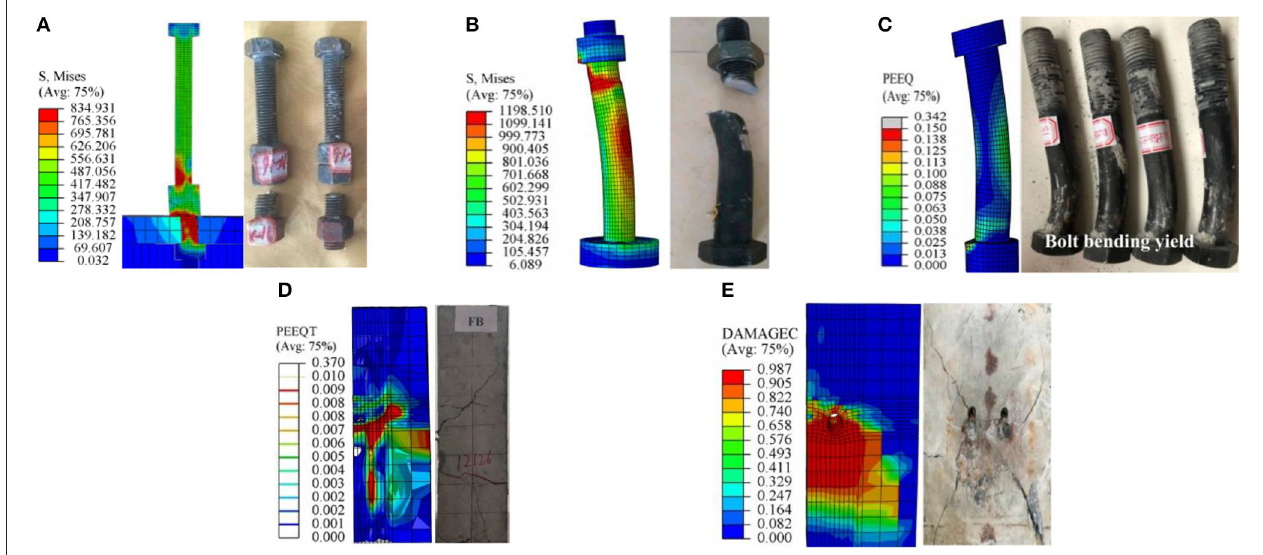
FIGURE 4 | Comparison of failure modes between finite element analysis (FEA) and tested results (Chen et al., 2019; Zhang et al., 2019, 2020): (A) bolt shear failure (T1-16 specimen); (B) bolt shear failure (T2-1 specimen); (C) bolt bending yield (NC-M27-G8.8 specimen); (D) concrete cracks (NC-M27-G8.8 specimen); and (E) concrete failure (T4-1